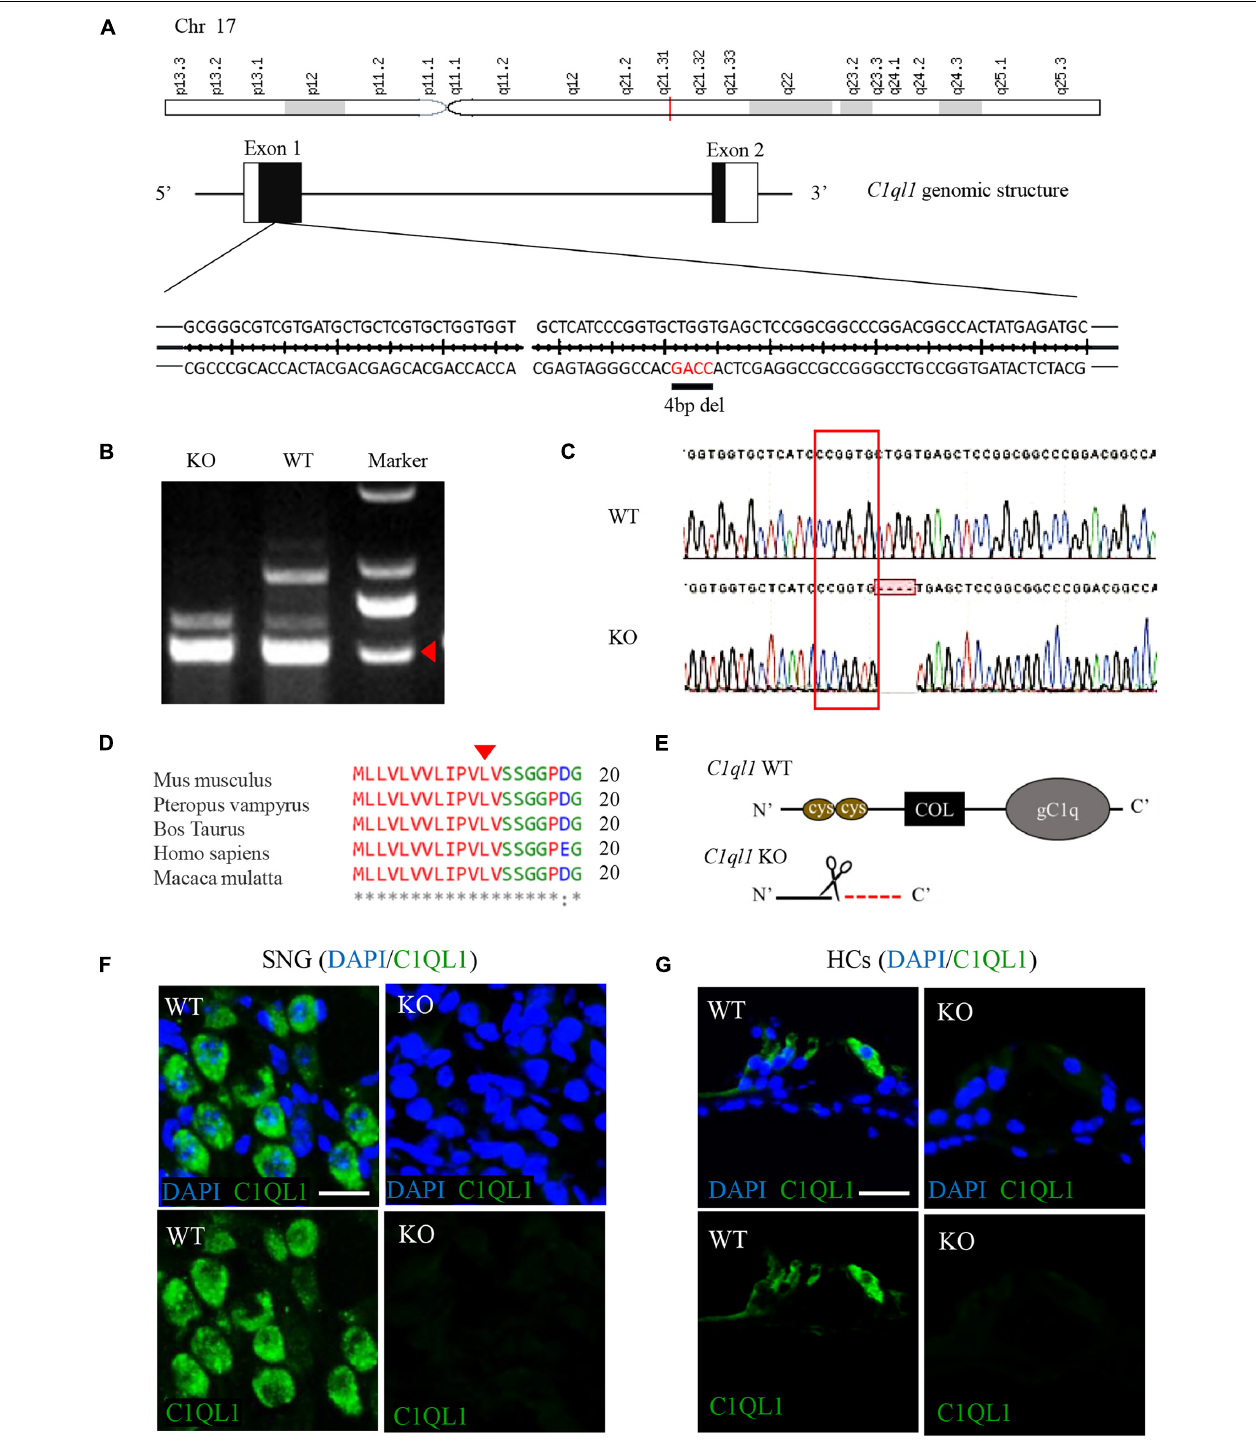
FIGURE 1 | Construction of C1ql1 knockout mice. (A) Mouse C1ql1 gene located in Chr17 contains two exons, and a 4 base-pair (bp) deleted at nucleotide 34 (c.34_37delCTGG) in the exon 1 revealed C1ql1 KO mice. (B) The different bands of C1ql1 gene sequencing between C1ql1 gene WT mice and C1ql1 gene KO mice. (C) The DNA sequencing of C1ql1 showed the c.34_37delCTGG mutation in C1ql1 KO mice. (D) The c.34_37delCTGG mutation was located in the height region between species. (E) The critical domains of C1QL1, and c.34_37delCTGG mutation resulted in domain deletions. (F) C1QL1 labeled by anti-C1QL1 (green) were detected in spiral ganglion cell of C1ql1 WT mice but not in C1ql1 KO mice. Scale bar = 10 µ m. (G) C1QL1 labeled by anti-C1QL1 (green) were also detected in hair cells of C1ql1 WT mice but is missing in C1ql1 KO mice. Scale bar = 10 µ m. Nucleus of cells were marked with DAPI (blue) in (F,G) .